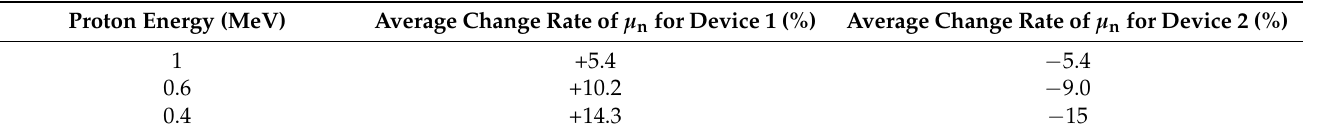
Figure 7. Gate–channel low-field electron mobility µ n of Device 2 before (“Pre-irradiation”) and after (“Irradiation”) proton irradiation as a function of gate voltage with 1 MeV ( a ), 0.6 MeV ( b ), and 0.4 MeV ( c ) proton energies. Table 1. Average change rate of µ n for Device 1 and Device 2 with 1 MeV, 0.6 MeV, and 0.4 MeV protons. Proton Energy (MeV) Average Change Rate of µ n for Device 1 (%) Average Change Rate of µ n for Device 2